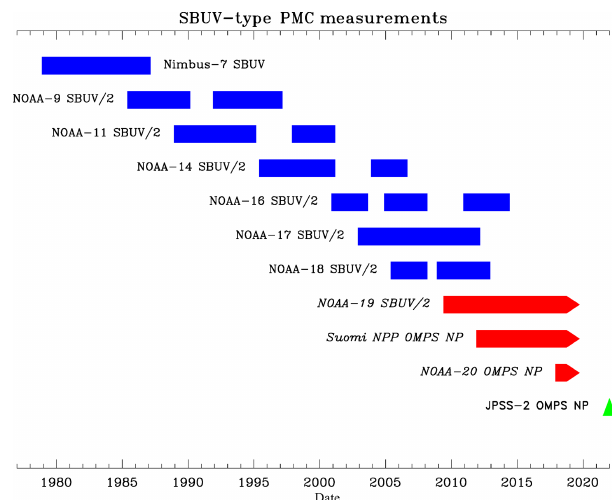
Figure 1. Timeline of SBUV instrument measurements used for PMC analysis. Blue color indicates inactive instruments. Arrow- heads and red color indicate active instruments. Green color in- dicates planned instrument. Gaps for many SBUV/2 instruments reflect satellite drift into a near-terminator orbit where the current PMC detection algorithm does not function